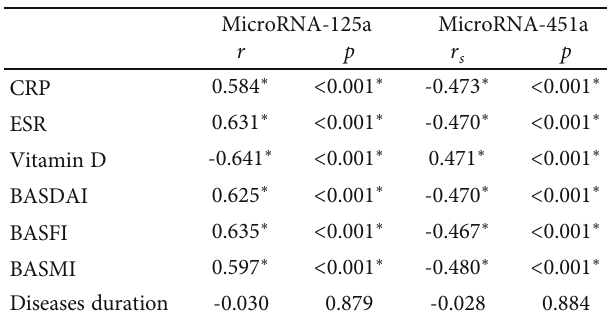
Table 2: Correlation between microRNA-125a and microRNA- 451a with laboratory parameters in the patient group ( n = 55